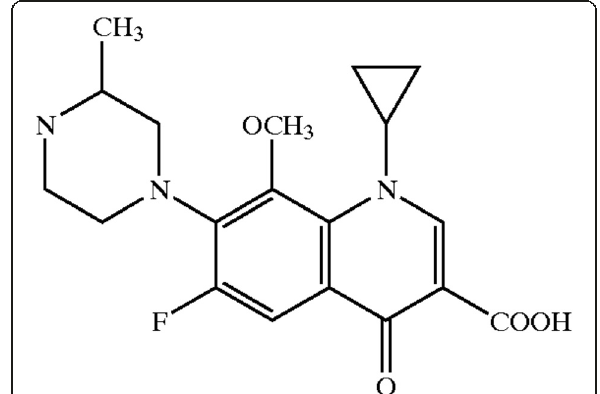
Fig. 10 Structure of